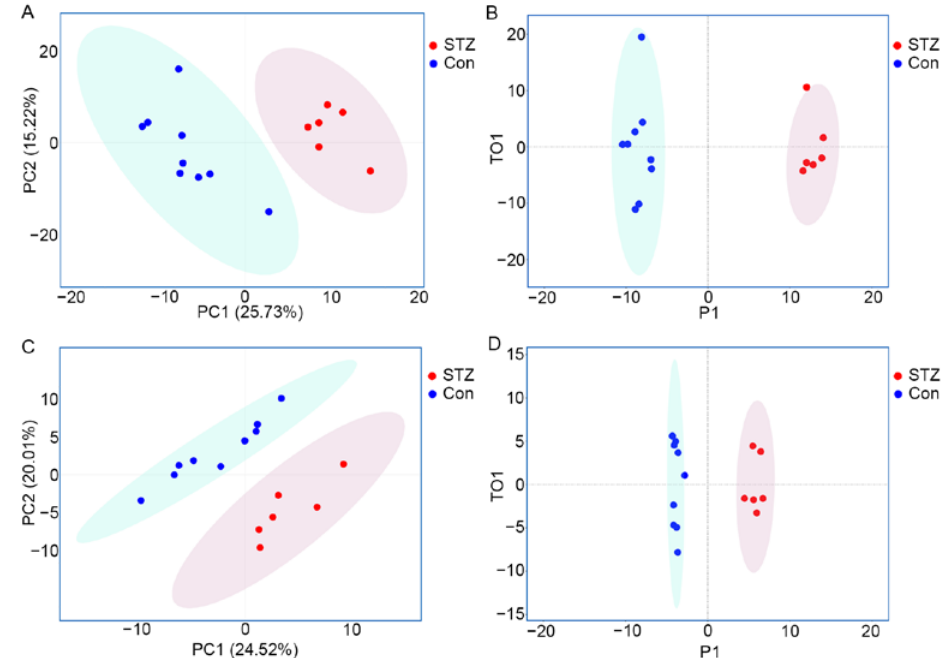
Figure 2. Principal component analysis of retinal metabolome profiles separates the STZ-induced DR group from controls. ( A ) Two-dimensional score plot of the PCA model comparing the control and STZ-induced diabetic group based on UHPLC-MS/MS; ( B ) Score plot of the OPLS-DA model based on UHPLC-MS/MS; ( C ) Two-dimensional score plot of the PCA model based on GC-MS; ( D ) Score plot of the OPLS-DA model based on GC-MS.